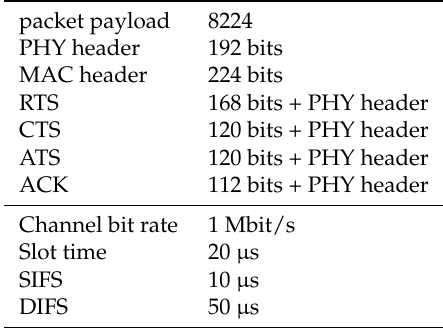
Table 2. Simulation